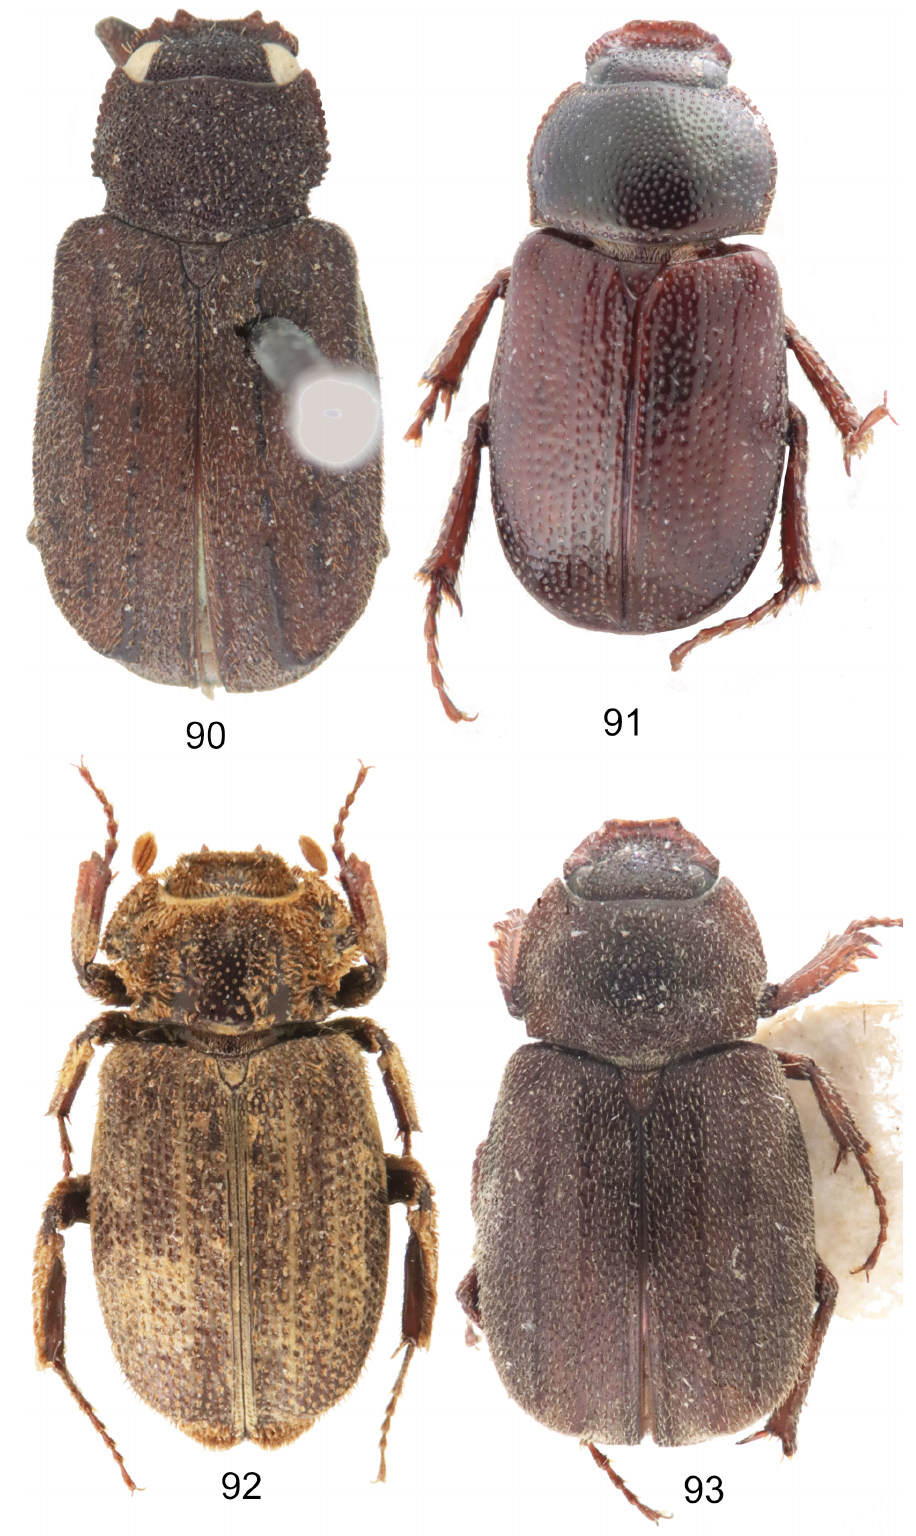
Figs 90–93. Papuan Maechidius Macleay, 1819, habitus, dorsal view. 90 . M. tarsalis Arrow, 1941, lectotype, ♂ (BMNH). 91 . M. trivialis sp. nov., holotype, ♂ (BMNH). 92 . M. ursus sp. nov., holotype, ♀ (NME). 93 . M. vicinus Heller, 1914, lectotype, ♀ (SNSD). Not to